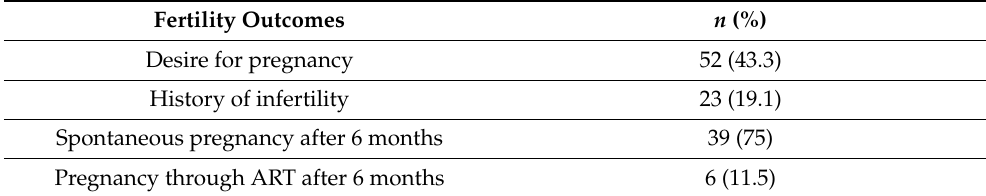
Table 3. Fertility outcome within 6 months of starting therapy with NAC. Fertility Outcomes n